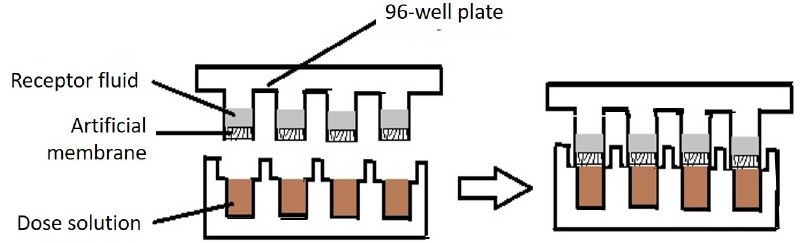
Figure 3. Typical parallel artificial membrane permeation assembly constituting the membrane between the donor and receptor fluid.